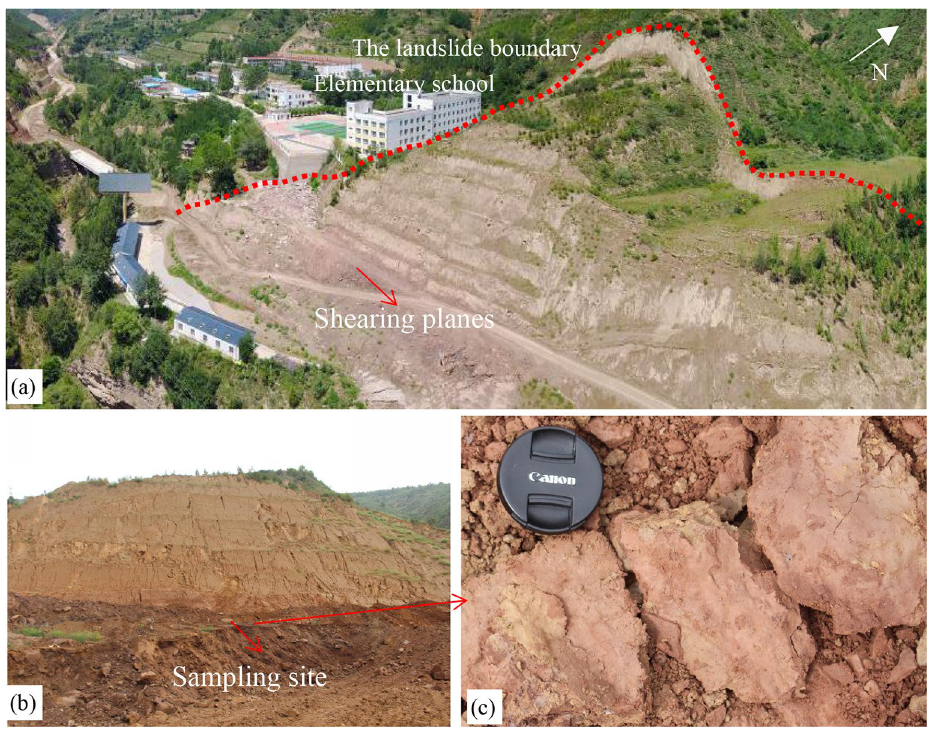
Figure 2. Sliding scratch surfaces and sampling site. ( a ) The landslide boundary; ( b ) sampling site; ( c ) sliding scratch surfaces.